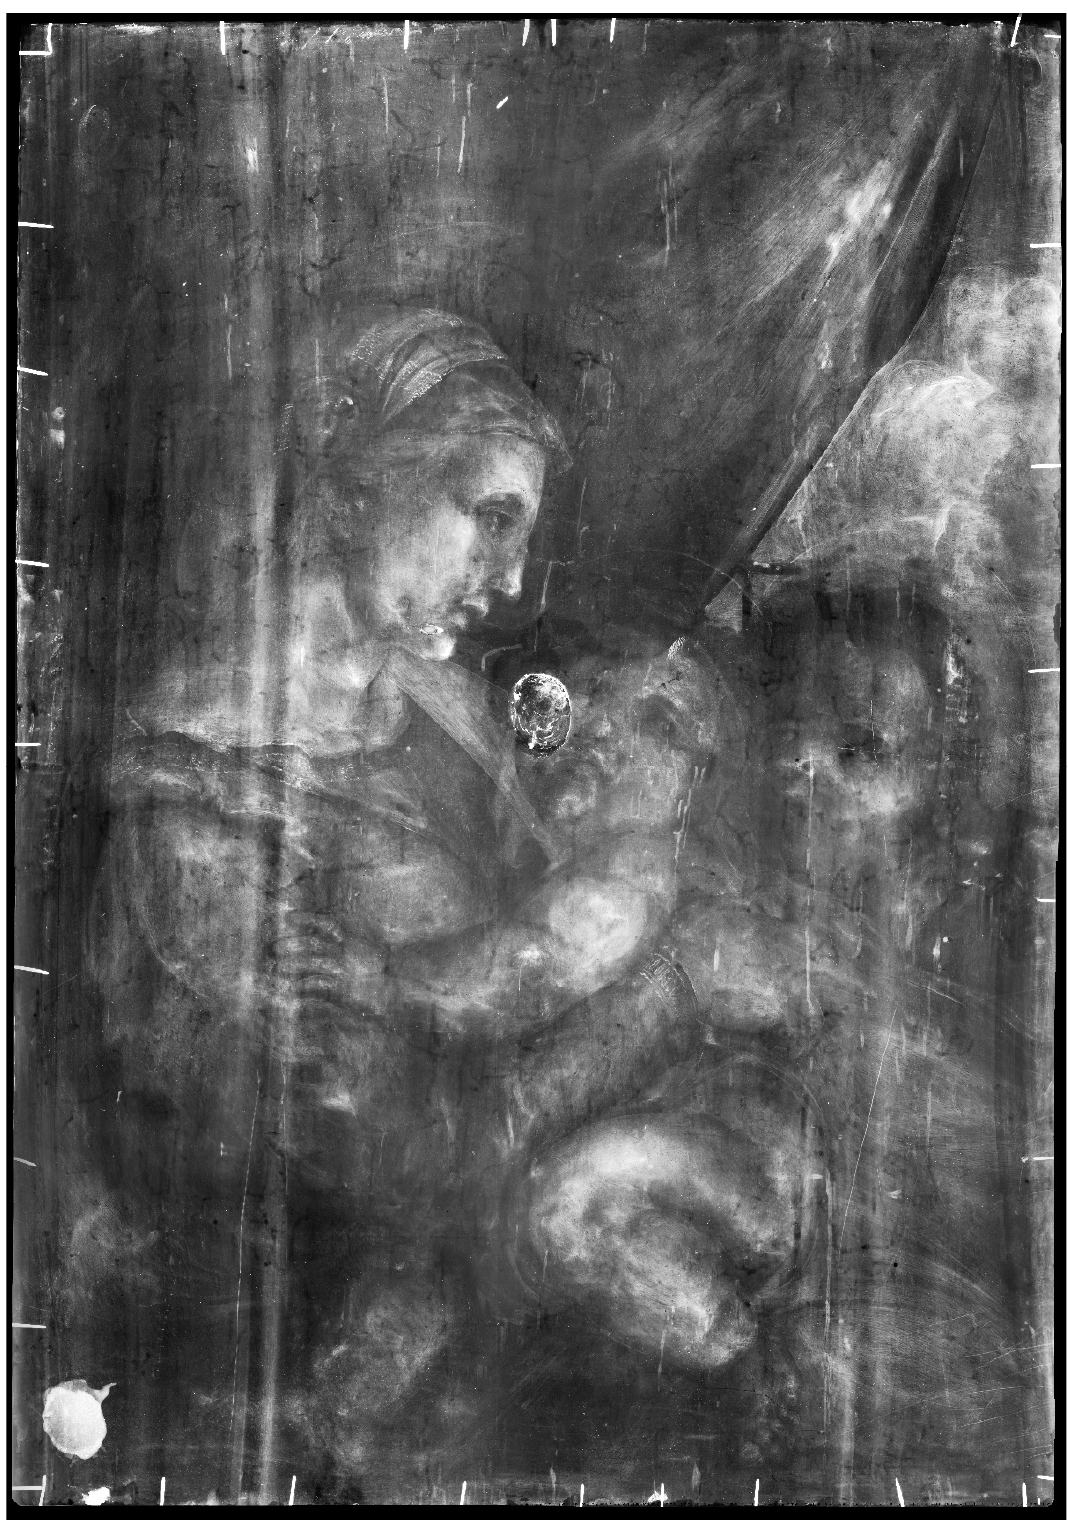
Figure 4. XR of the painting showing the pattern of wood grains of the support (much less noticeable in the central stripe) and the numerous woodworm tunnels following the pattern of the wood fibers.